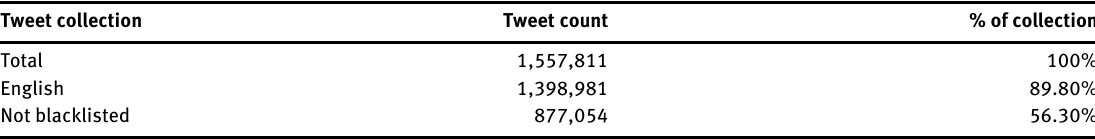
Table 6: Statistics on Stored Tweets for Company-Centric